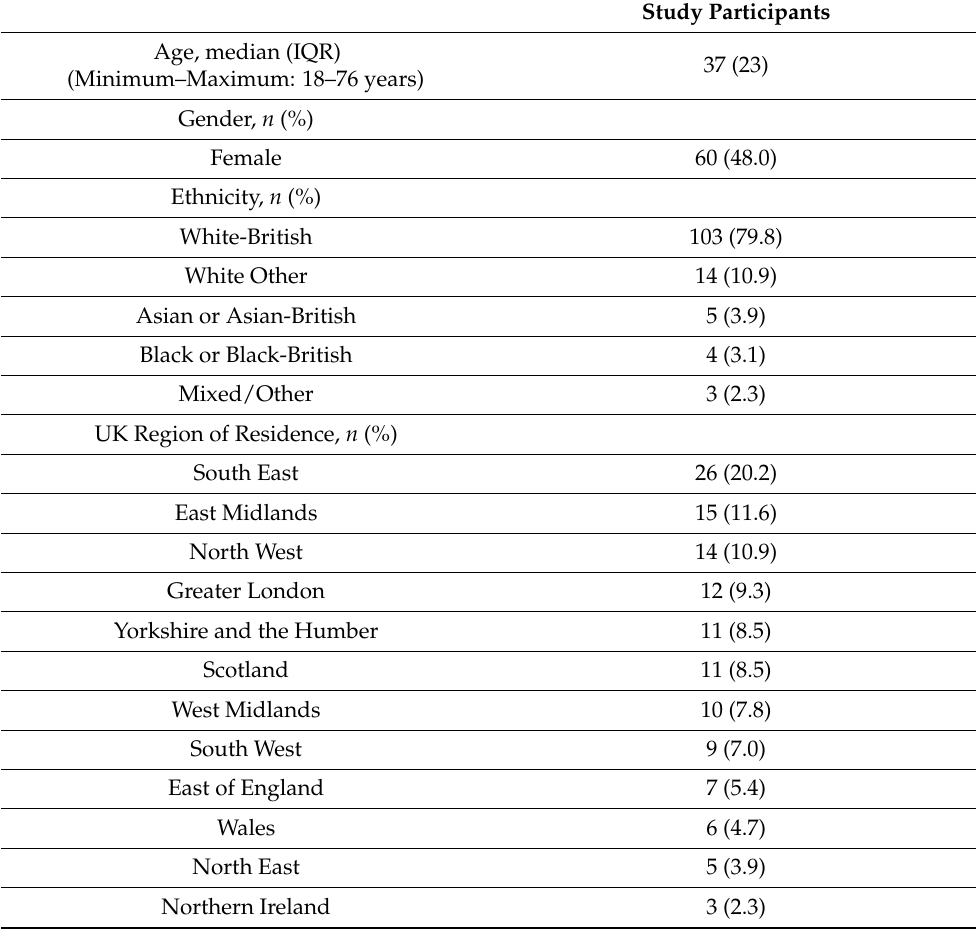
Table 1. Characteristics of study participants ( n =